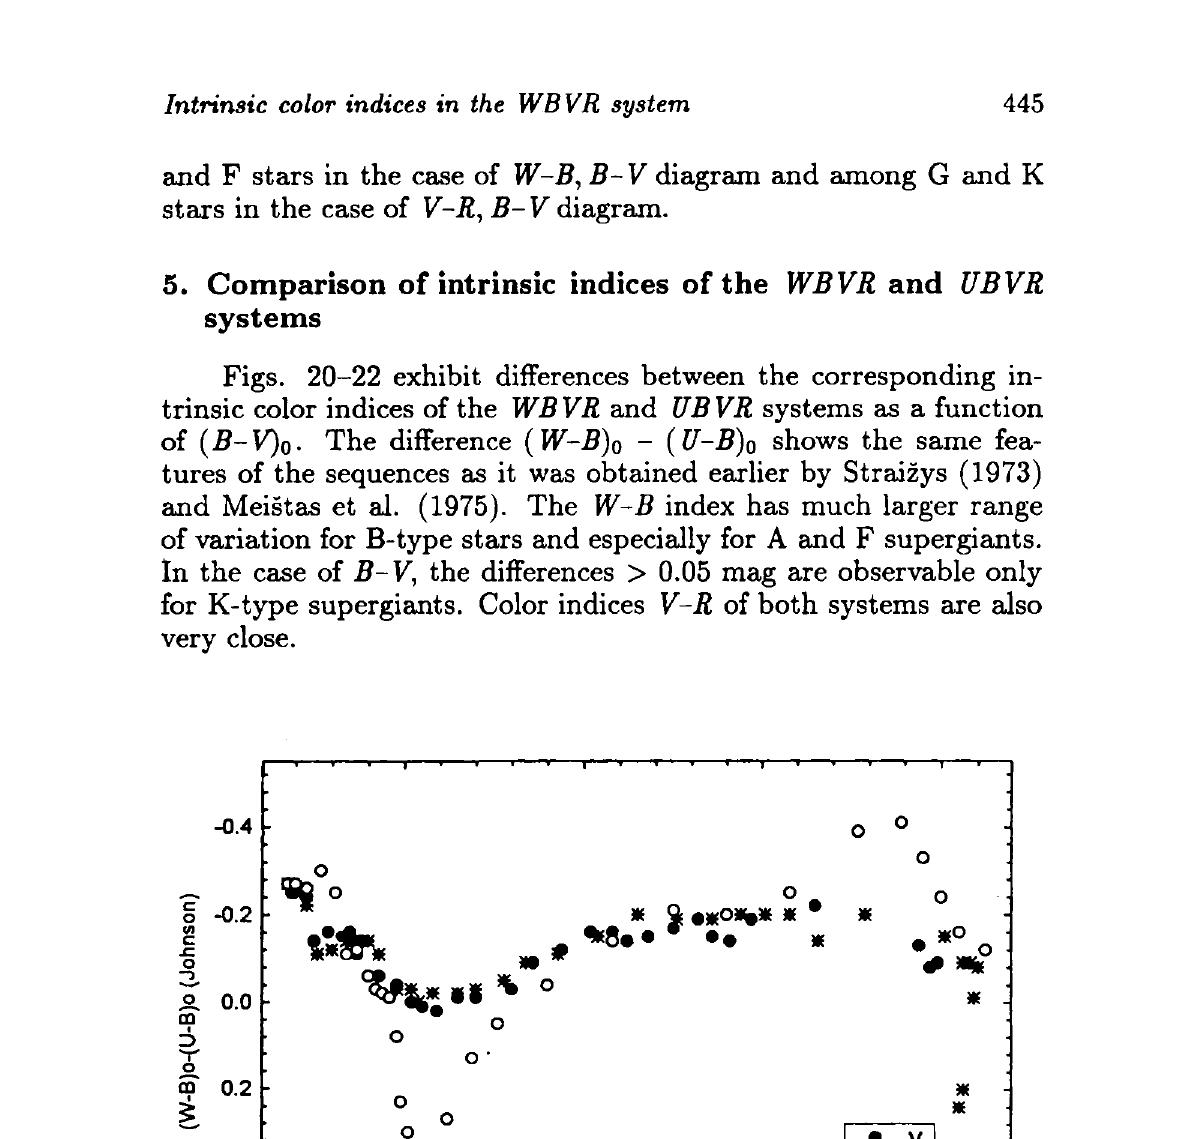
Fig. 20. The difference of the intrinsic color indices ( W-B) o and (U-B) o of the WBVR and the UBVR systems, as a function of (B-V)